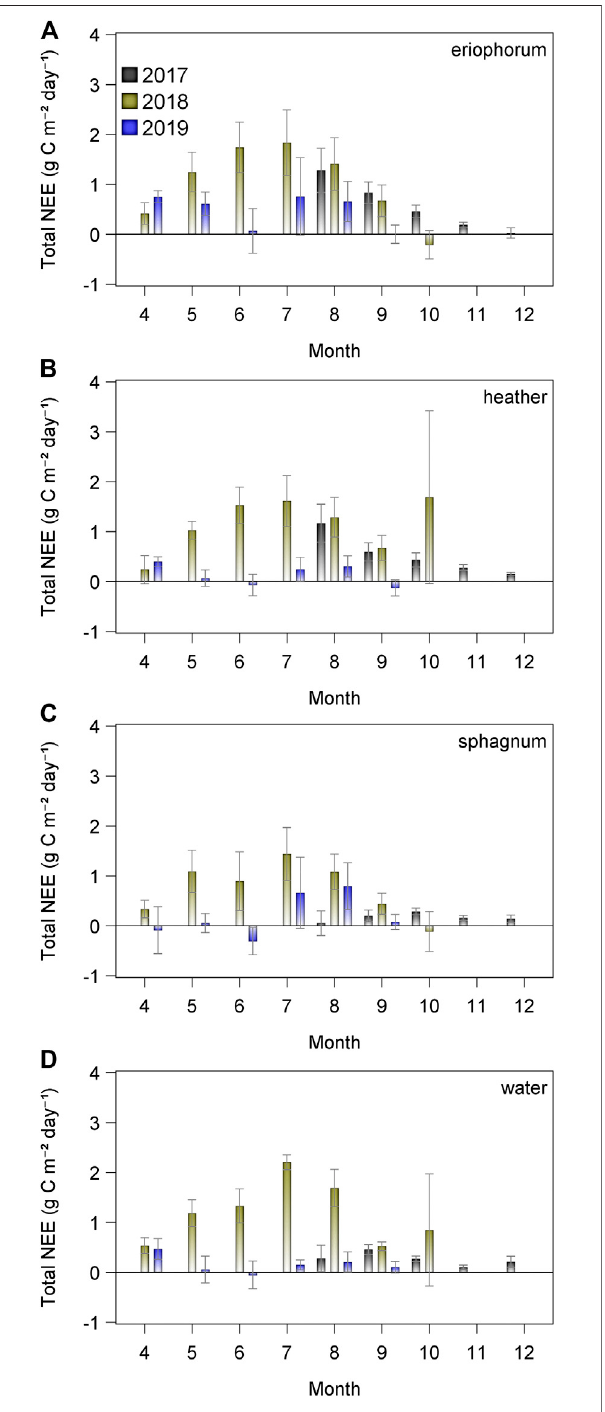
FIGURE 5 | Total monthly fl ux of CO 2 from each ecotype (n (cid:2) 6, ± 1SE) for 2017 (black), 2018 (olive) and 2019 (blue).